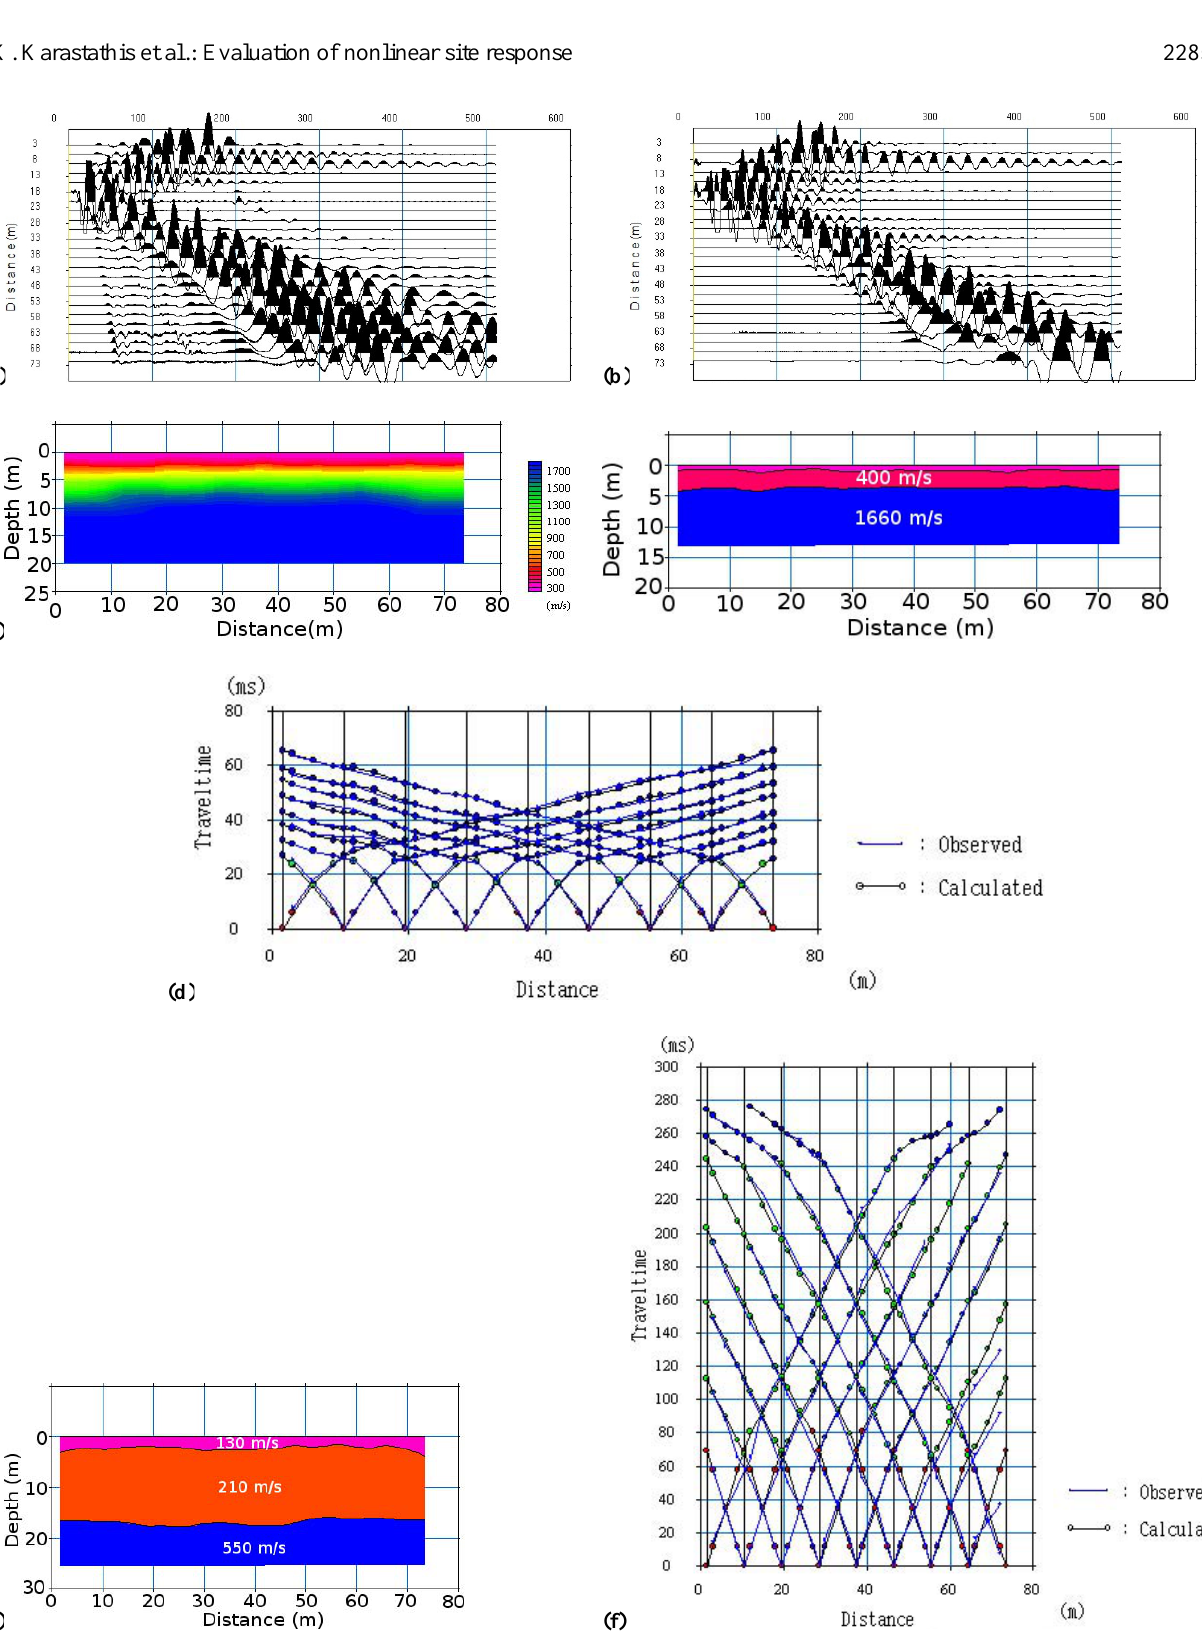
Fig. 4. (a) Example seismic record from the P-wave refraction profile DD 0 . (b) Example seismic record from the respective S-wave refraction profile. The source and the geophones positions remained the same. (c) Tomographic and statigraphic model as resulted from the processing of the P-wave data. (d) The traveltime curves of the picked and calculated P-wave arrivals. (e) The stratigraphic model as resulted from the processing of the S-wave data and (f) the curves of the picked and calculated S-wave